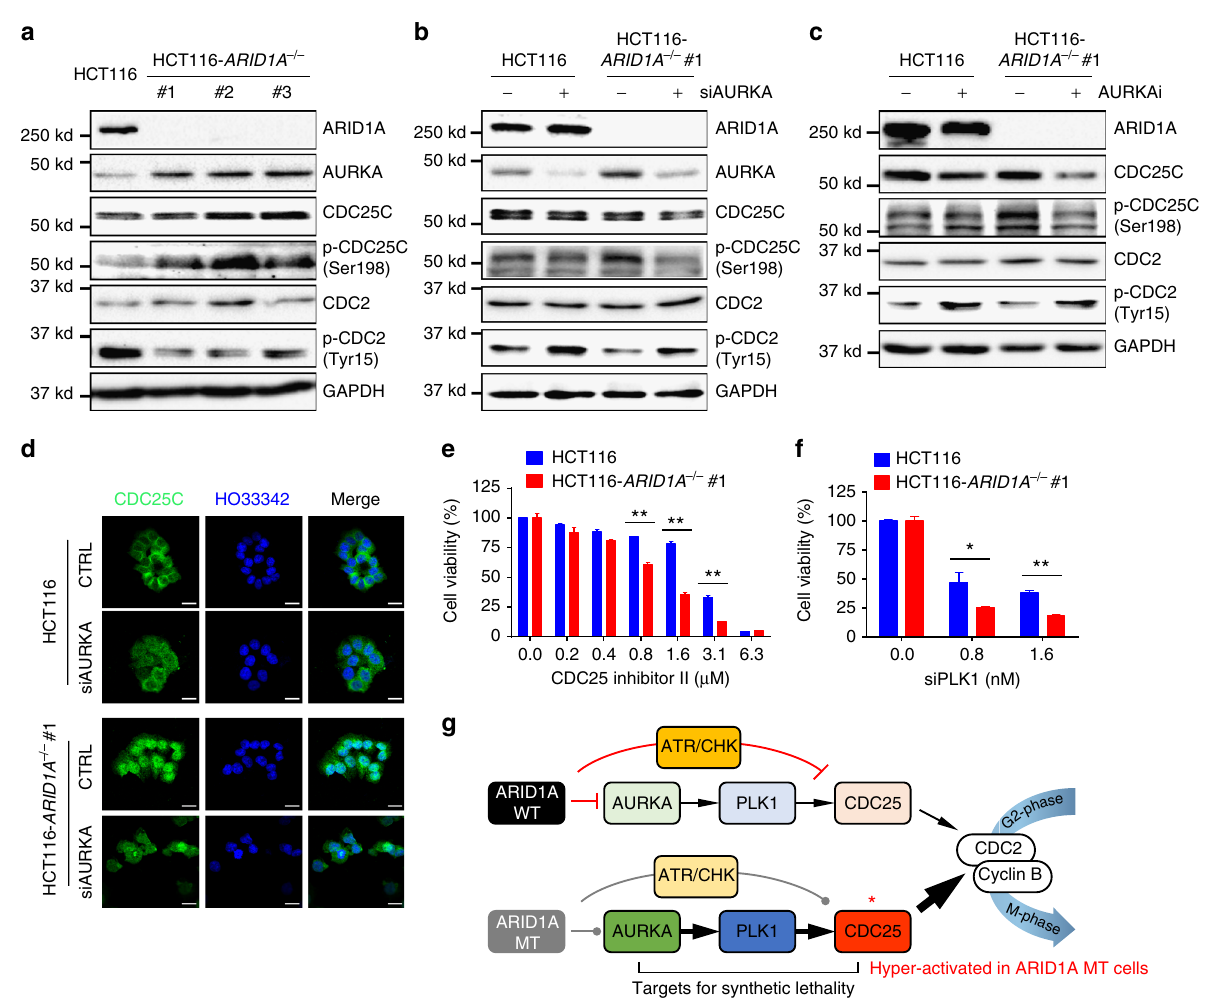
Fig. 6 AURKA – CDC25C axis is a target for synthetic lethality in ARID1A-KO colorectal cancer cells. a Immunoblots showing upregulation of AURKA and phosphorylated CDC25C at Ser198 levels and downregulation of phosphorylated CDC2 at Tyr15 level in ARID1A − / − HCT116 cells. b , c Inhibition of CDC25C phosphorylation at Ser198 and increased phosphorylation of CDC2 at Tyr15 by AURKA silencing ( b ) and AURKAi treatment ( c ). d Immuno fl uorescence analysis of CDC25C localization in ARID1A isogenic cells treated with or without AURKA siRNA. Scale bars, 20 µ m. e Synthetic lethality in ARID1A − / − HCT116 cells by CDC25 inhibitor II. f Synthetic lethality in ARID1A − / − HCT116 cells by PLK1 siRNA (siPLK1). Error bars represent s.d. * P < 0.05; ** P < 0.01, Student ’ s t test. g Working model of the synthetic lethality between ARID1A and AURKA. In ARID1A wild-type (WT) cells, AURKA expression is negatively regulated by ARID1A, thereby reducing the activity of AURKA downstream pathway, including PLK1 and CDC25C. In ARID1A mutant (MT) cells, AURKA-PLK1-CDC25C pathway is upregulated. In addition, CDC25C activity is negatively regulated by ARID1A – ATR – CHK (checkpoint kinase) pathway under DNA damage conditions, thereby strictly controlling the CDC25 activity in ARID1A WT cells. In ARID1A MT cells, ARID1A – ATR – CHK pathways is impaired and thus CDC25C activity is de-repressed, causing it in hyper-active state. In this condition, cells can be addicted to AURKA – CDC25C pathway for cell survival and proliferation. Therefore, AURKA – CDC25C axis becomes a target for synthetic lethality in